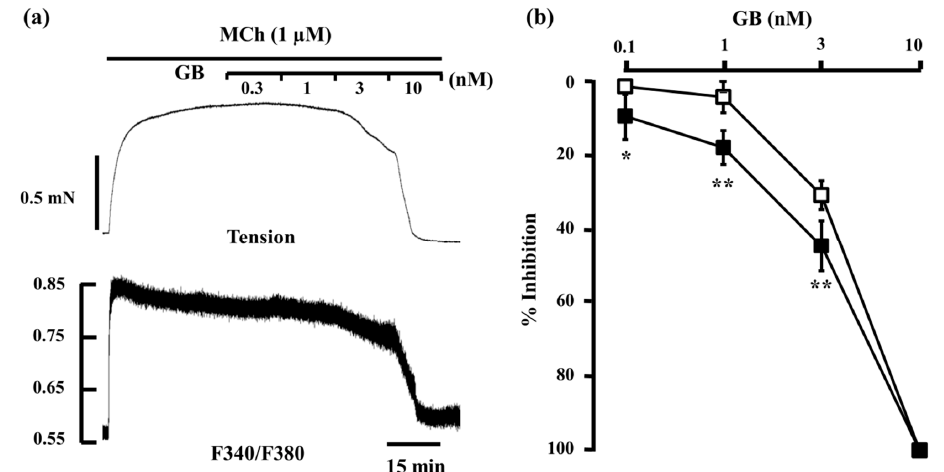
Figure 3. Involvement of intracellular Ca 2+ dynamics in the relaxant effect of glycopyrronium. ( a ) Typical sample of continuous recording of tension and F340/F380 demonstrating the inhibitory effect of glycopyrronium (0.3–10 nM) on MCh (1 μ M)-induced contraction; ( b ) Concentration–response curve for glycopyrronium (0.1–10 nM) in tension ( □ ) and F340/F380 ( ■ ) induced by MCh (1 μ M). GB, glycopyrronium bromide; MCh, methacholine. ** p < 0.01; * p < 0.05.